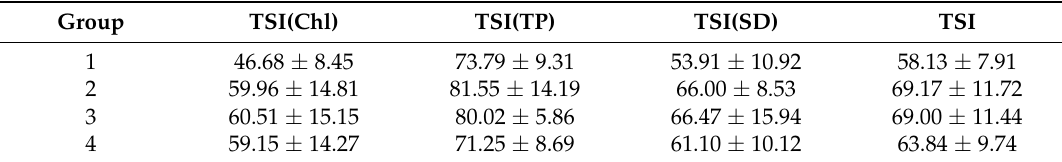
Table 3. Values of Carlson’s trophic state index (TSI) and its components (TSI based on